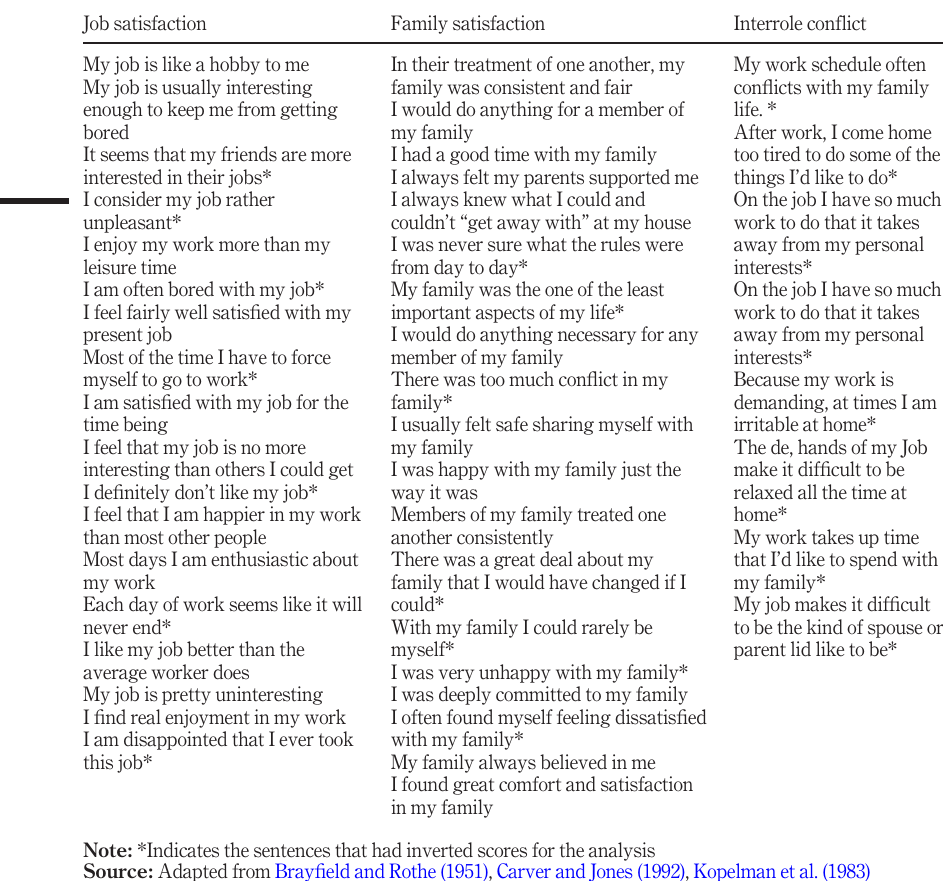
Age Up to 3 months